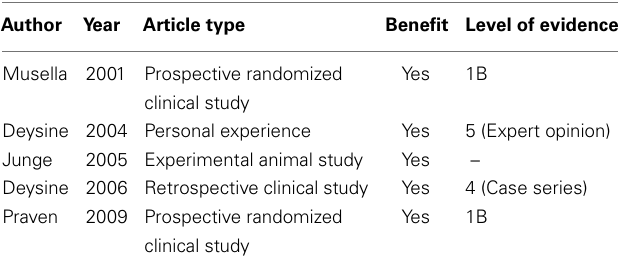
Table 1 |A summary of data regarding topical gentamycine for SSI prophylaxis in inguinal hernia repairs